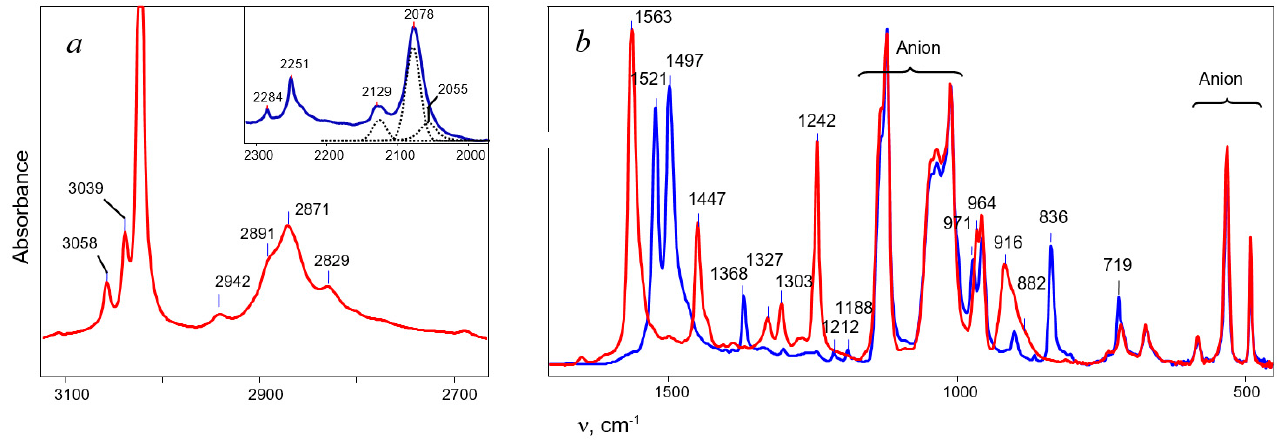
Figure 12. IR spectra in transmittance of the protium-(red) and deuterium-(blue) C 4 H 5 + carbocation in their salts with the {Cl 11 − } anion in the frequency range of CH stretches ( a ) and below 1600 cm − 1 ( b ). The intensities of both spectra are reduced to unit anion intensity.